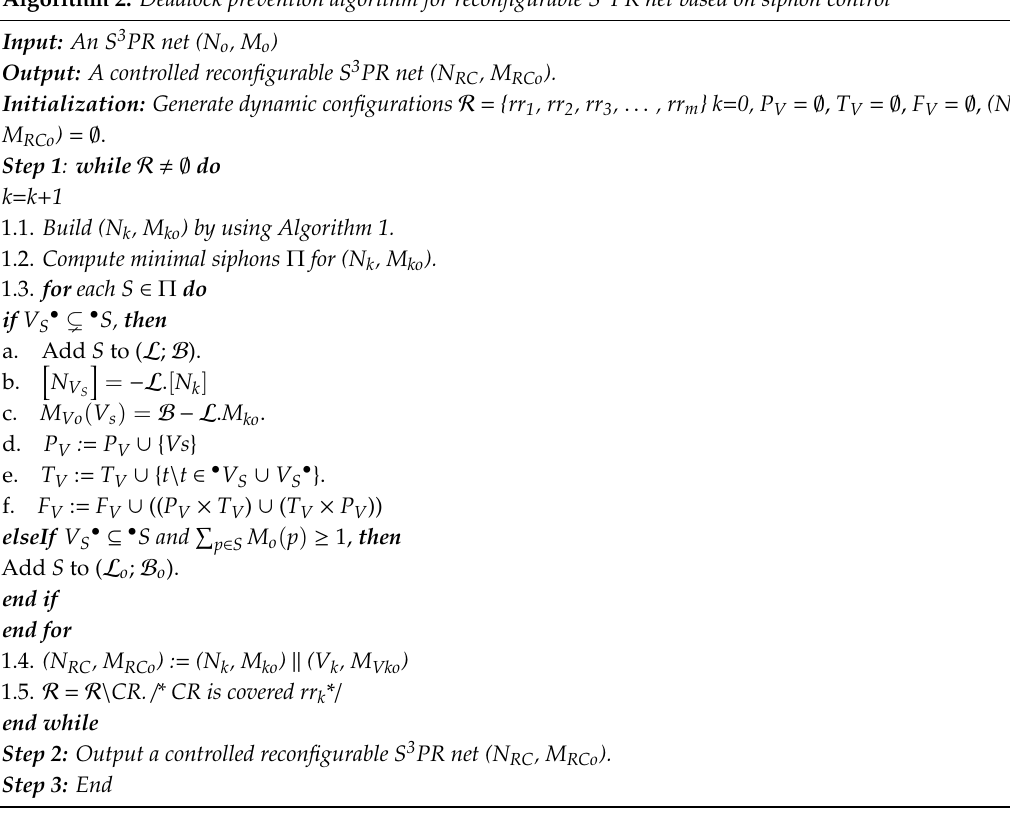
Algorithm 2: Deadlock prevention algorithm for reconfigurable S 3 PR net based on siphon